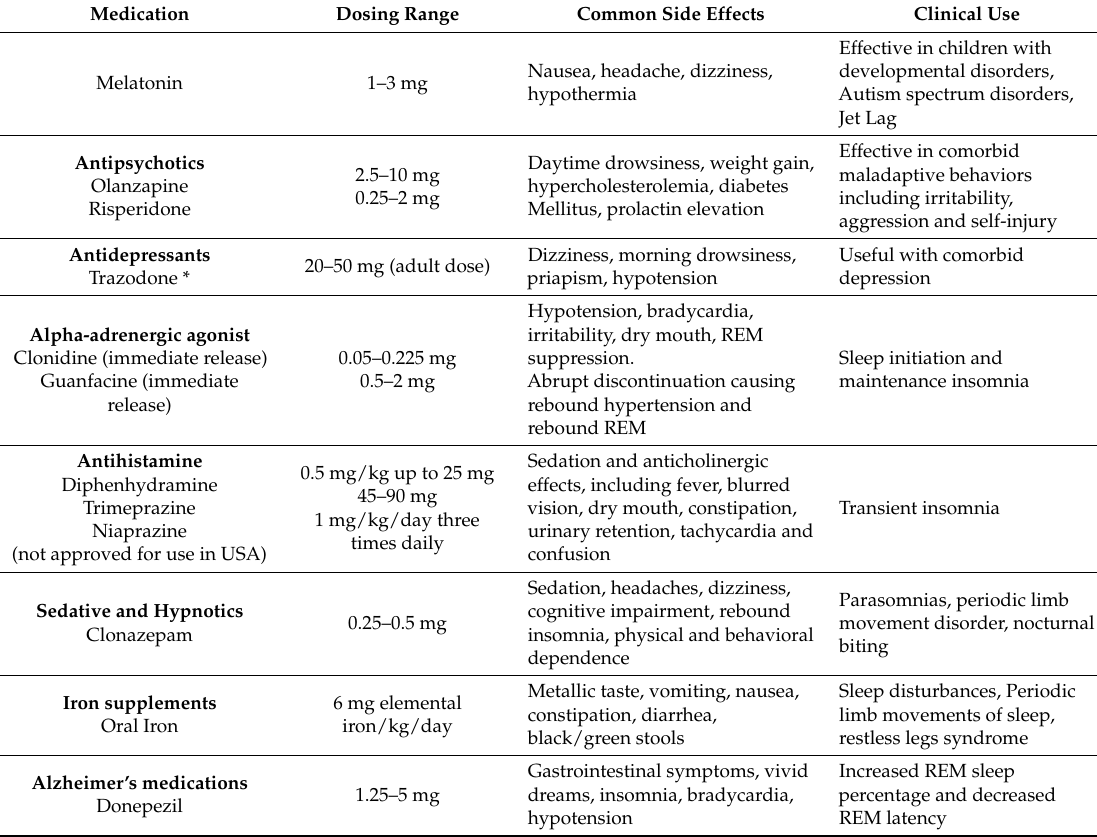
Table 1. Selected medications for sleep referenced in the publications on autism spectrum disorder (ASD) and psychiatric